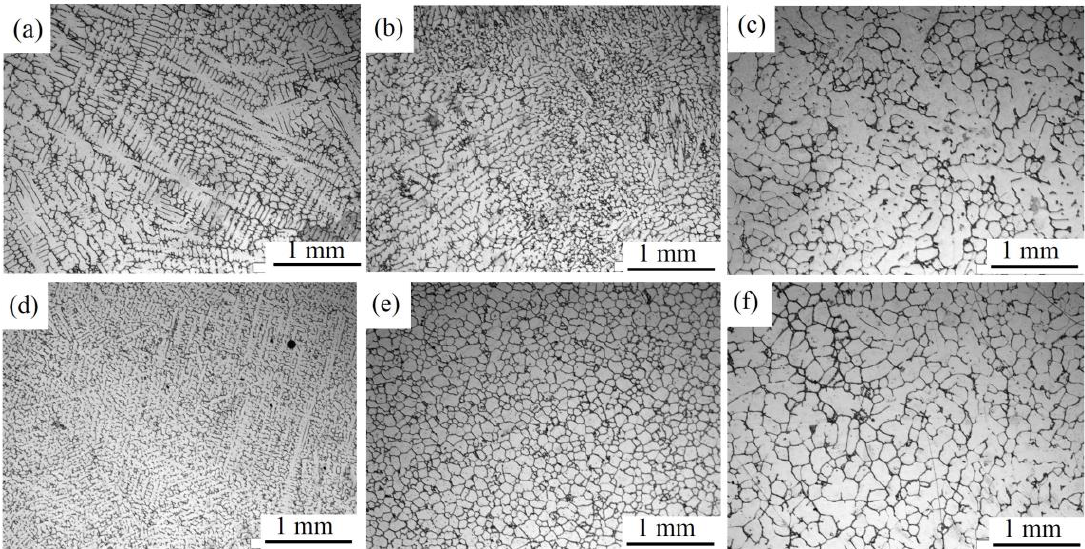
Figure 7. Microstructure of Ni-Cr-W superalloy by isothermal treatment at various temperatures with various conditions: ( a – c ) Non-sheared by electromagnetic field (EMF); ( d – f ) sheared by electromagnetic field; ( a , d ) isothermal treatment at 1420 °C; ( b , e ) isothermal treatment at 1400 °C; ( c – f ) isothermal treatment at 1390 °C.